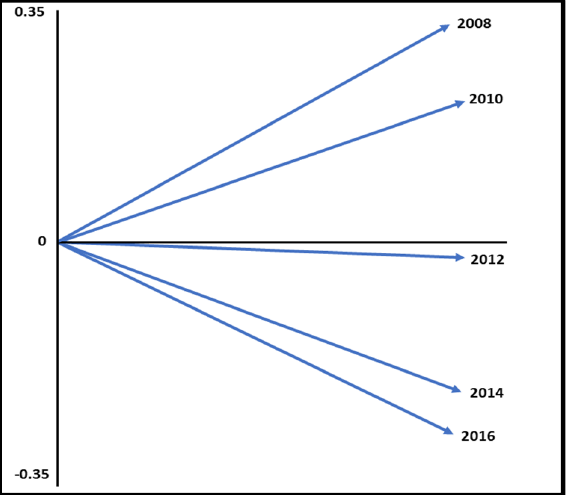
Figure 3. X − Statis Interestructure plot.